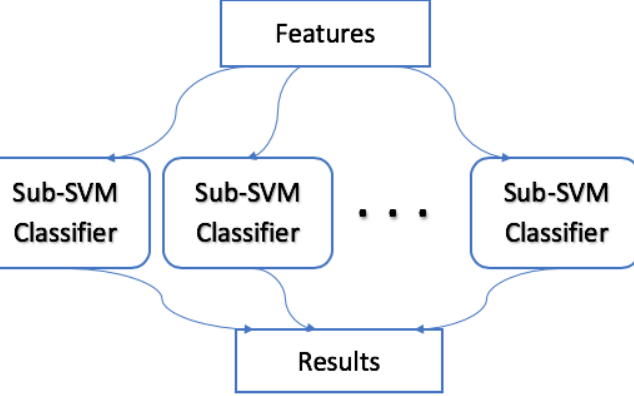
Figure 6. Illustration of the classification process using multiple sub-SVM classifiers.